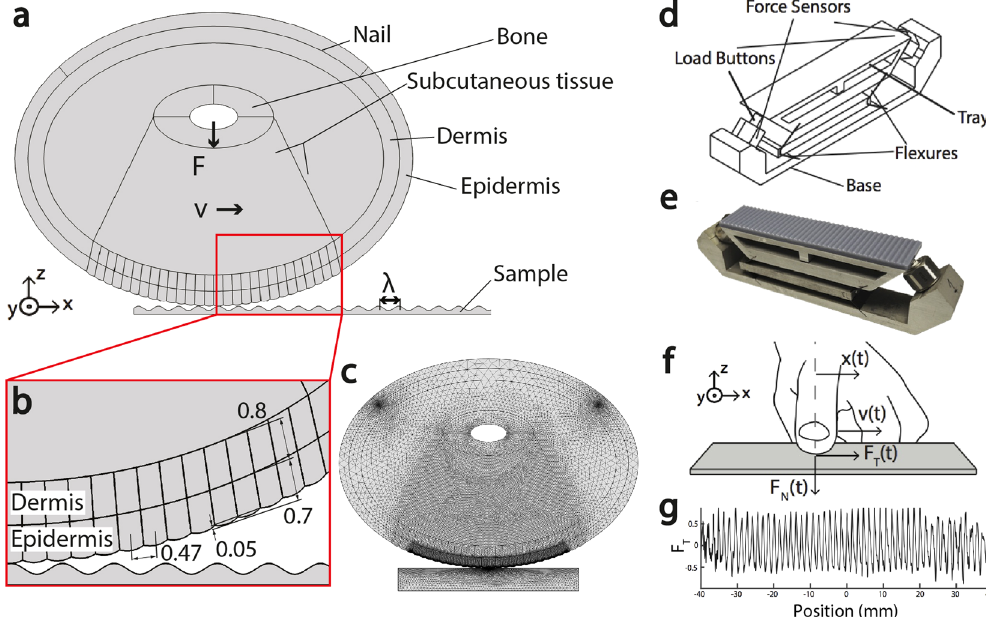
Figure 4. ( a ) Two-dimensional multi-layer FEM model of the fingertip and ( b ) detailed view (mm) sliding over a textured surface with sinusoidal shape. The simulations differ in the surface wavelength ( λ = 1, 2, 3 mm), fingertip velocity ( v = 80, 120 mm/s) and the initial fingertip position. The touch force of the fingertip for all six conditions is F = 0.3 N. ( c ) Meshing of the fingertip and flat surface into plane stress triangle elements, showing the finer meshing in the contact region of the finger ( d ) Isometric illustration of the apparatus that was used to record real frictional interactions between finger and textured surface ( e ) Description of a finger, sliding over a flat surface fingertip with position x(t), scanning speed v(t), and contact forces F N and F T ( f ) Photo of the apparatus with sinusoidal surface sample on top ( g ) Typical example of normalized frictional force signal, produced during sliding of the finger over a sinusoidal grating ( λ = 1